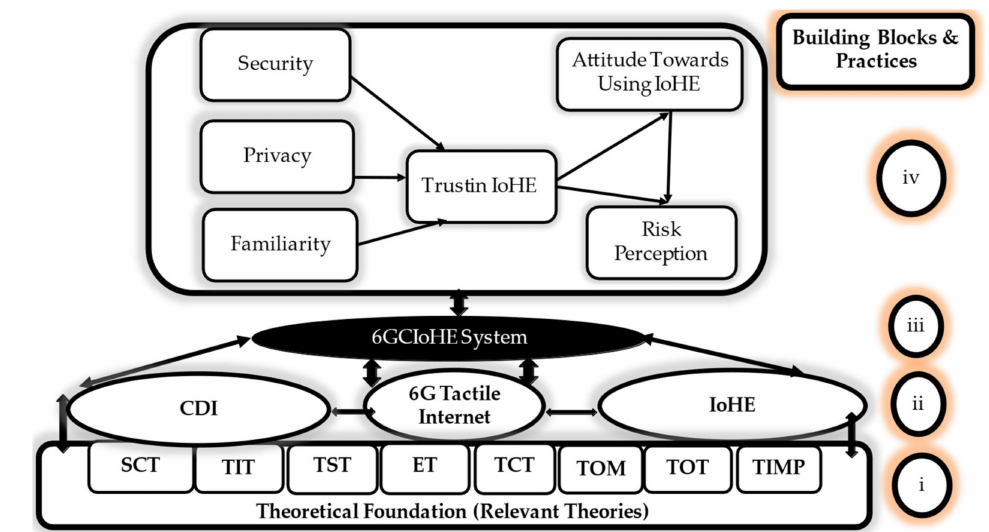
Figure 16. The 6GCIoHE system theoretical